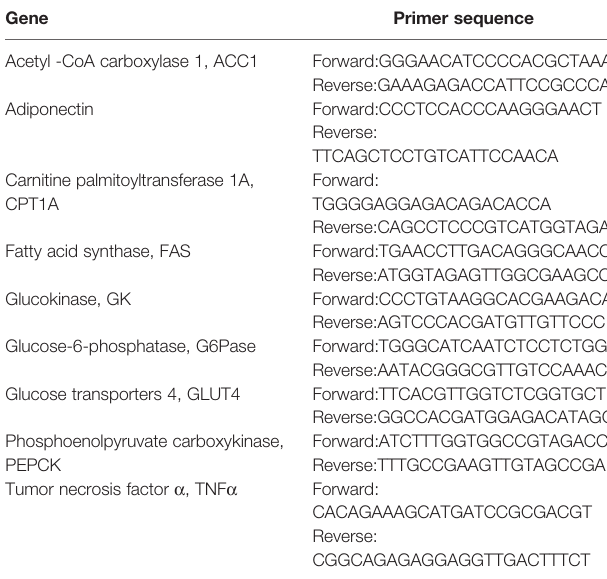
TABLE 1 | Primer sequences for metabolic related